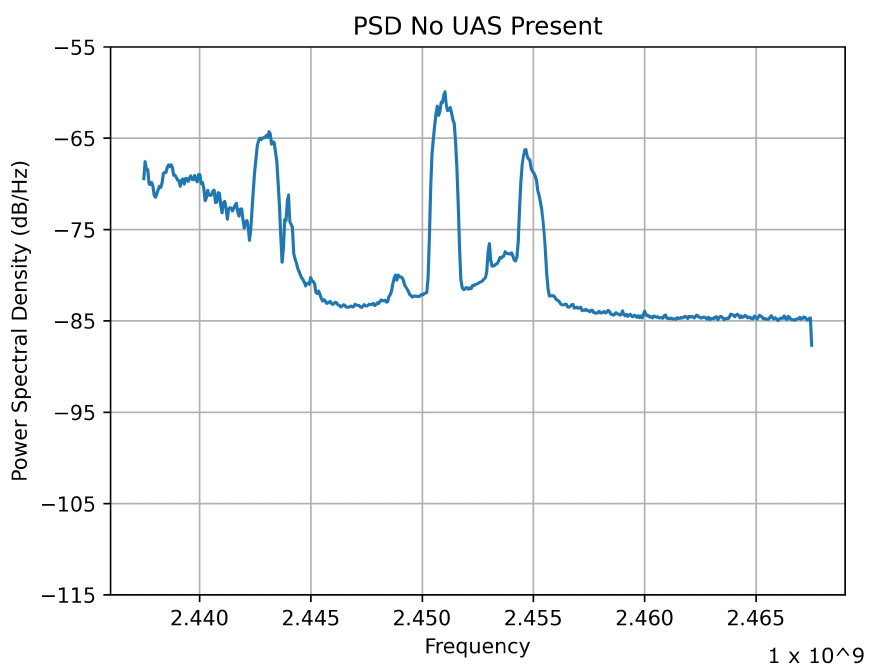
Figure 3. PSD: No UAS present. Figures 4 and 5 show Phantom 4 when it is switched on in the presence of Bluetooth and Wi-Fi interference in spectrogram and PSD representations, respectively. We can see some clear activity in the lower end of the spectrum.